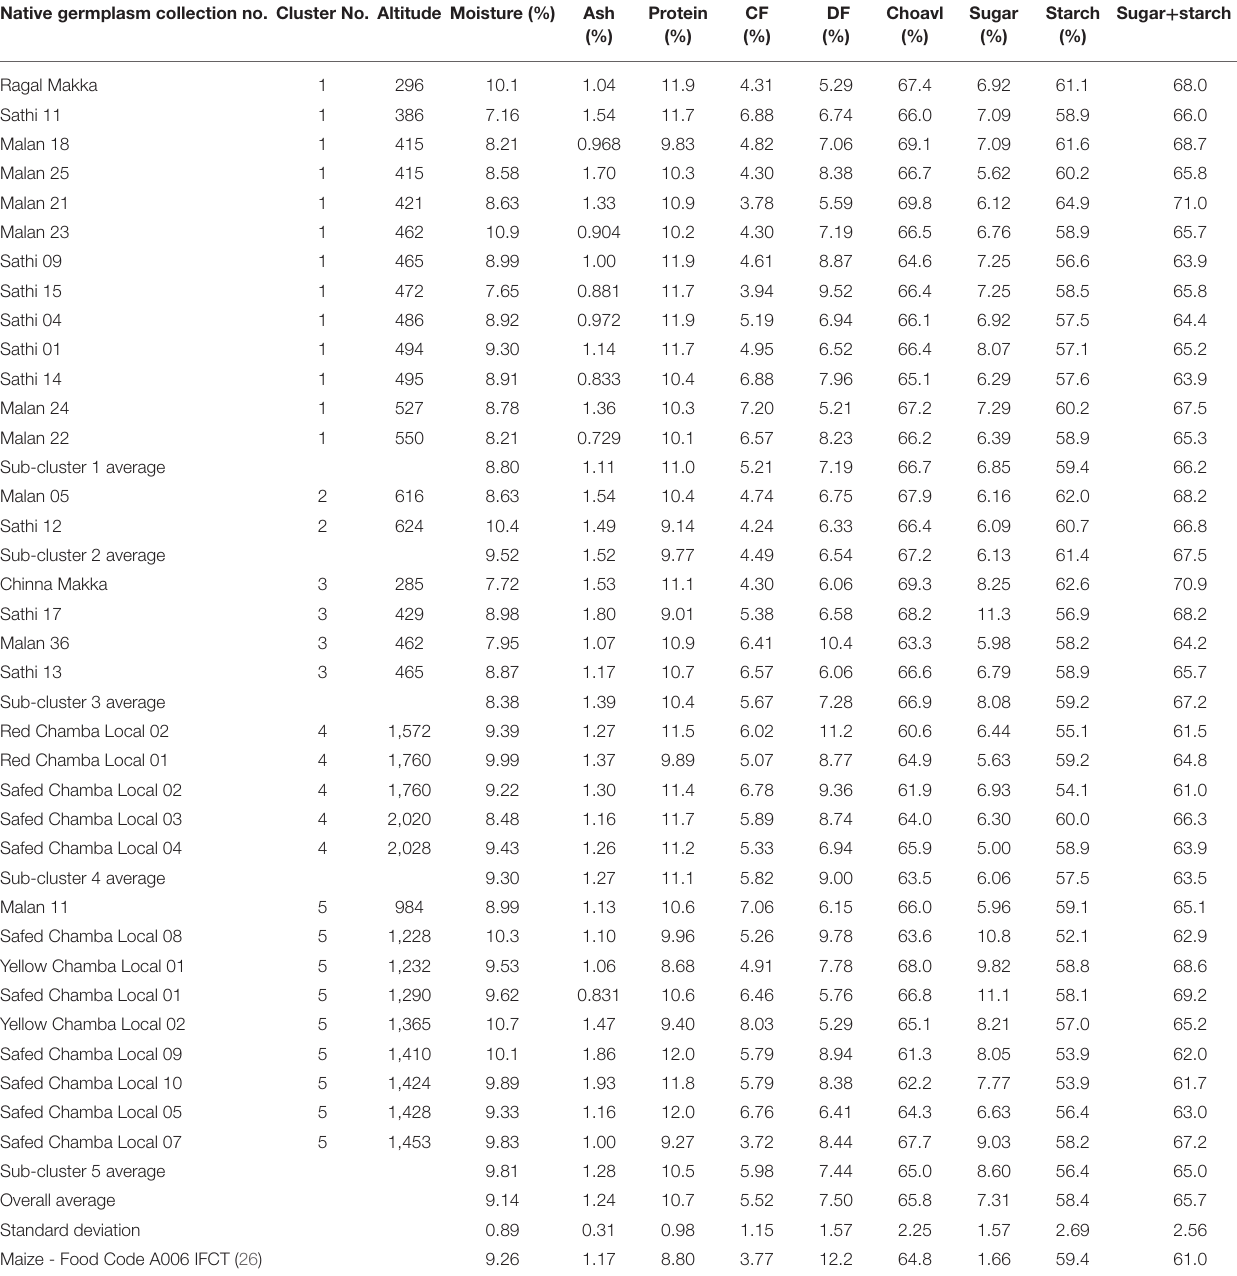
TABLE 2A | Variability in proximate composition, total soluble sugar and total starch content in maize germplasm. Native germplasm collection no. Cluster No. Altitude Moisture